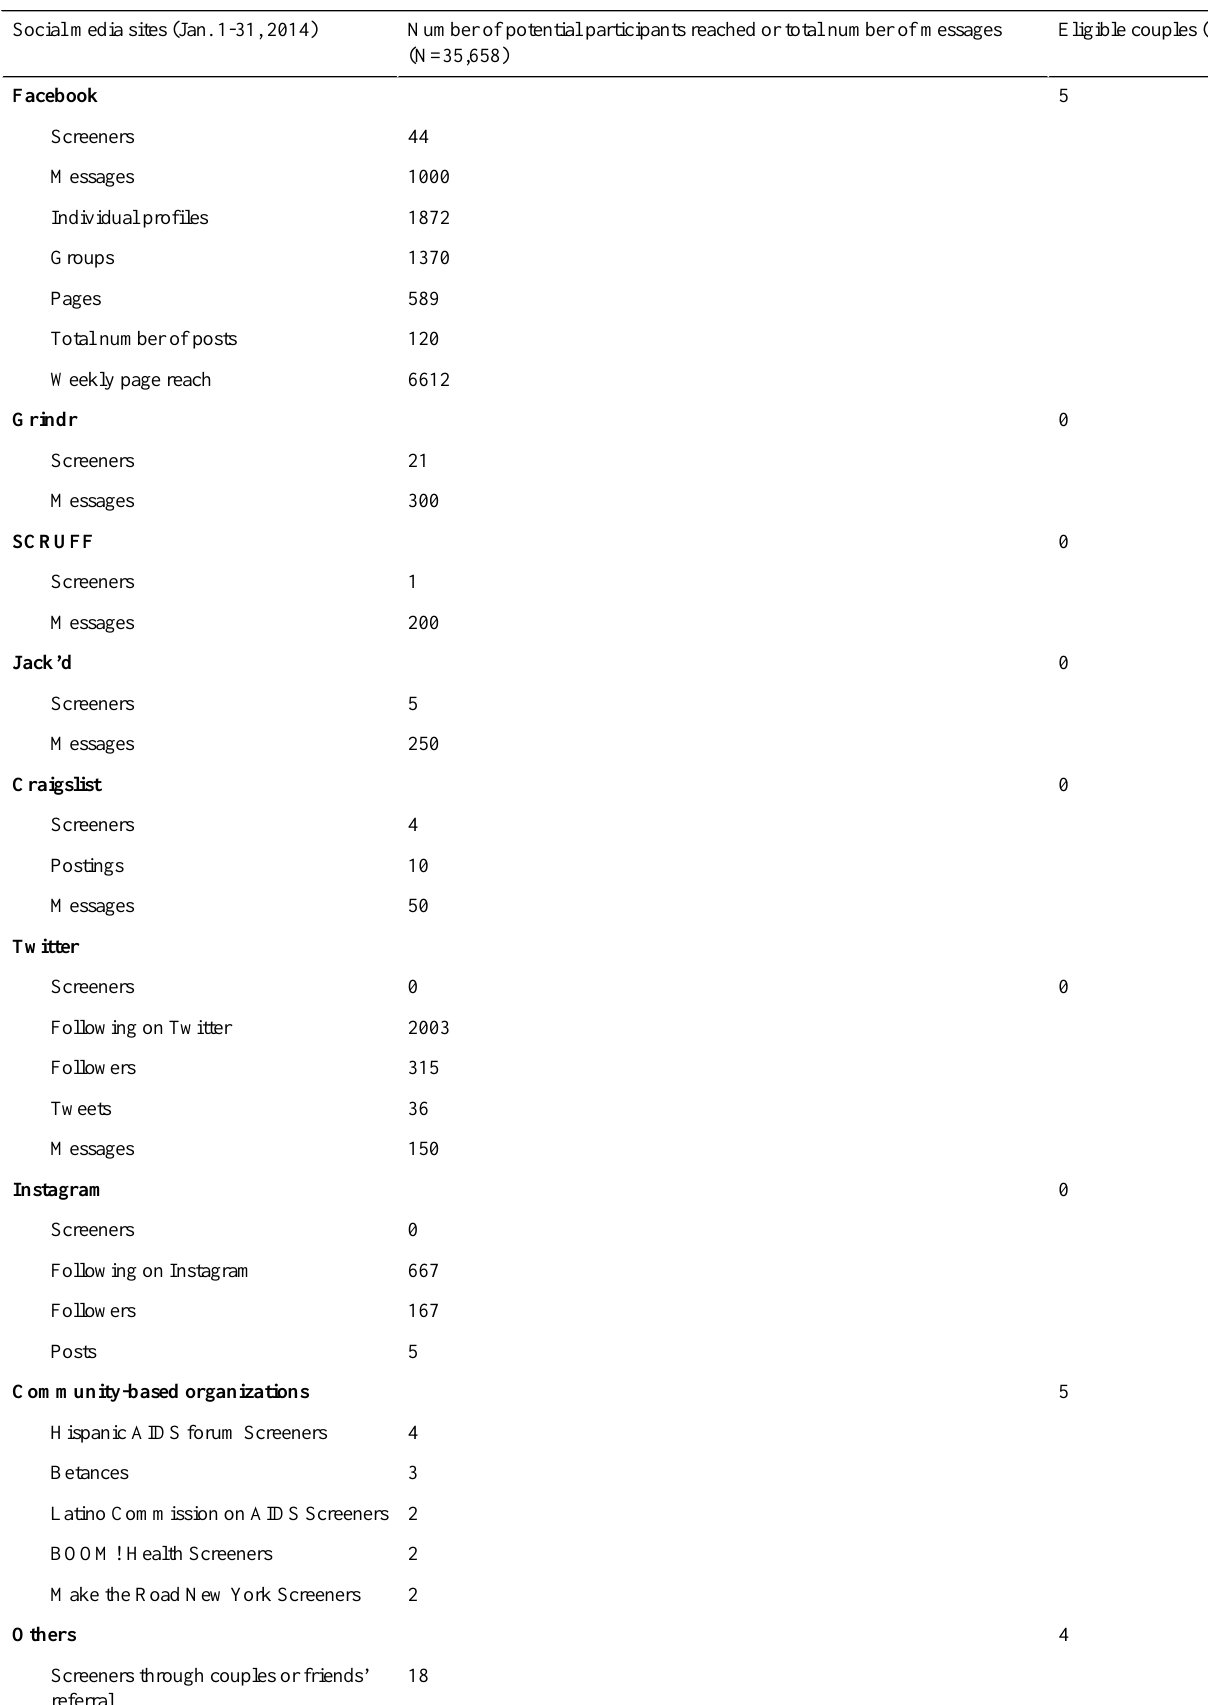
Table 1. Summary of recruitment reach through social media channels and community-based